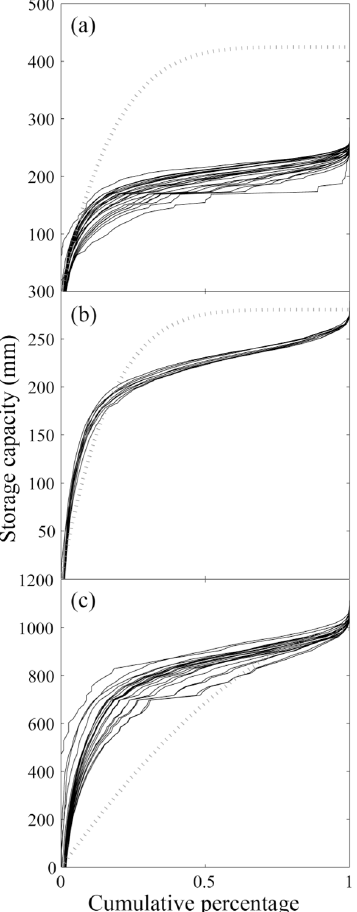
Fig. 9. Cumulative distributions of storage capacity for the VIC and TRG algorithms for (a) Willamette River basin (b) Eel River basin, and (c) Dongjiang River